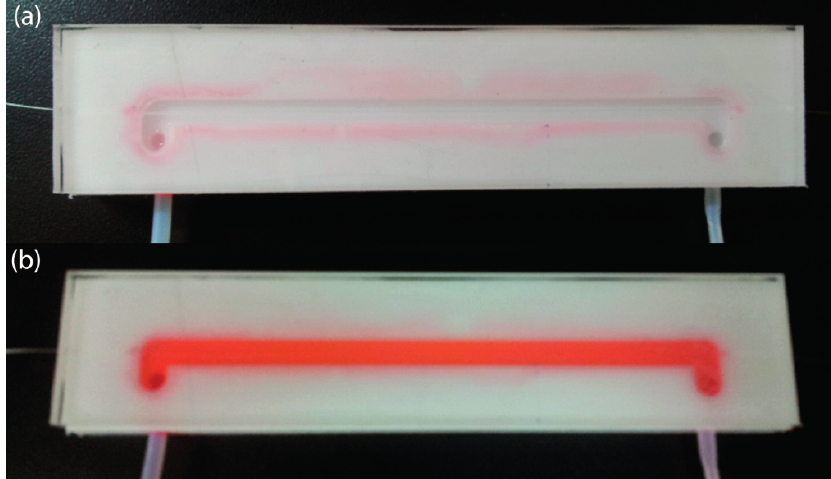
Figure 3. MMI sensor fixed into the Delrin channel with glass cover ( a ) without gasohol and ( b ) with gasohol. Red dye is added to the gasohol solution to highlight the gasohol in the